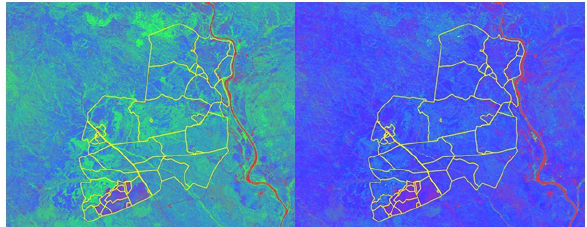
Figure 4. Ground cover mapping example for a property in northern Queensland during the late dry season (RGB = bare, green and non-green fractions). The left image shows the fractional cover product, and the right image shows the ground cover fraction product. The ground cover product reveals that there is a significant amount of non-green vegetation on the ground surface beneath the tree and shrub overstorey.